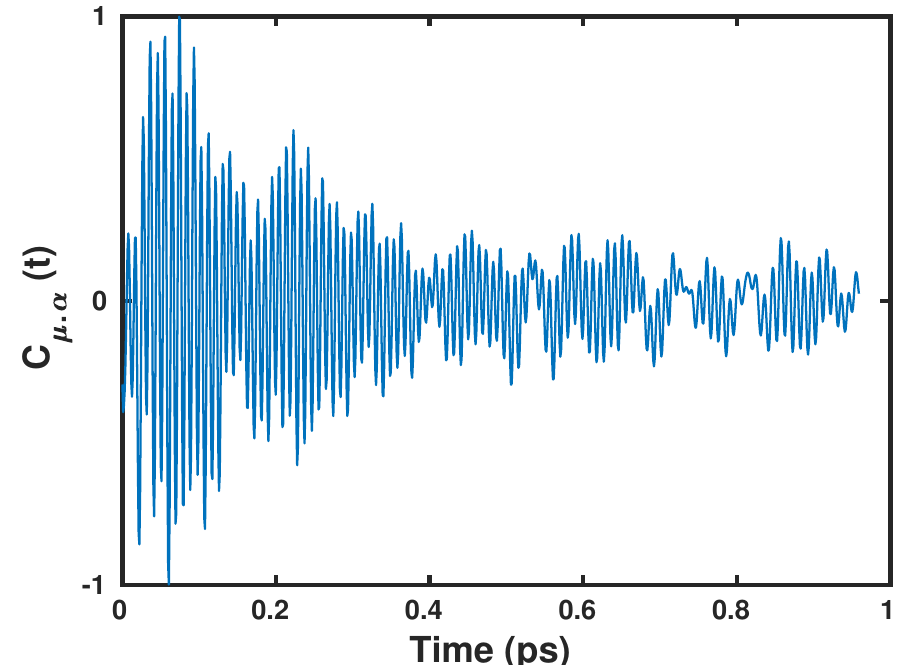
Figure 2. The dipole polarizability cross-correlation function, as obtained by the present anisotropic Wannier Polarizability (WP)